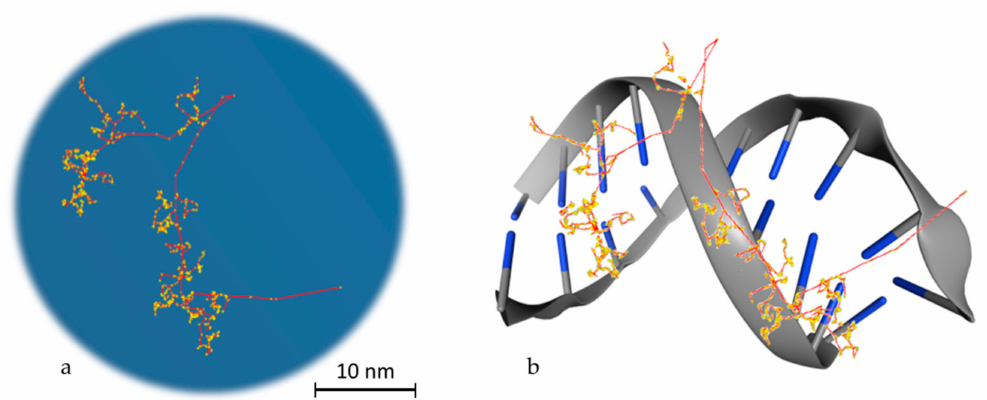
Figure 2. Particle transport example. ( a ) Track structure of an electron (10 KeV) in water as simulated in Geant4-DNA. The red line, which starts from the bottom right edge, is the route followed by the primary electron, while in yellow the interactions with the water medium are presented. The red branches that are separated from the main route represent secondary electrons. ( b ) Schematic representation of the way that energy is deposited on DNA molecules. This is a stylish representation, which has the aim of helping the reader understand the way that the superposition of energy deposition in water is transformed to single or double strand breaks. The blue edges imitate DNA